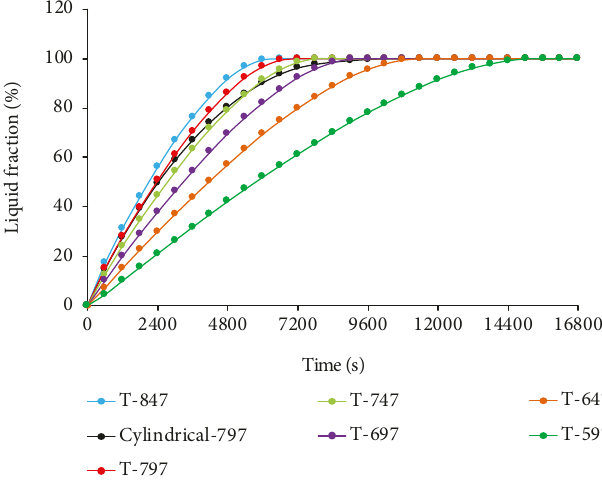
Figure 6: E ff ects of inlet temperature of HTF on liquid fraction.